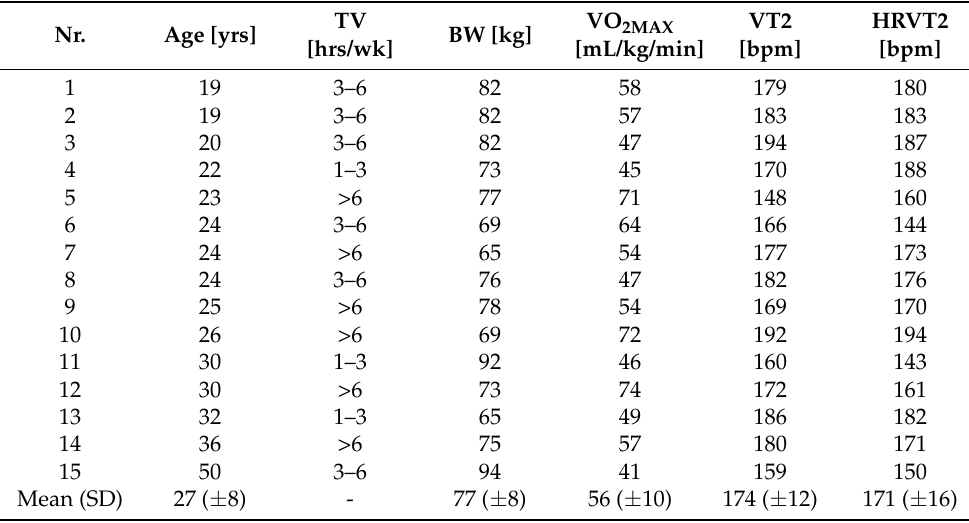
Table 1. Age, training volume (TV), bodyweight (BW), maximal oxygen uptake (VO 2MAX ), Oxynet- derived HR at VT2 and HR at HRVT2 for all